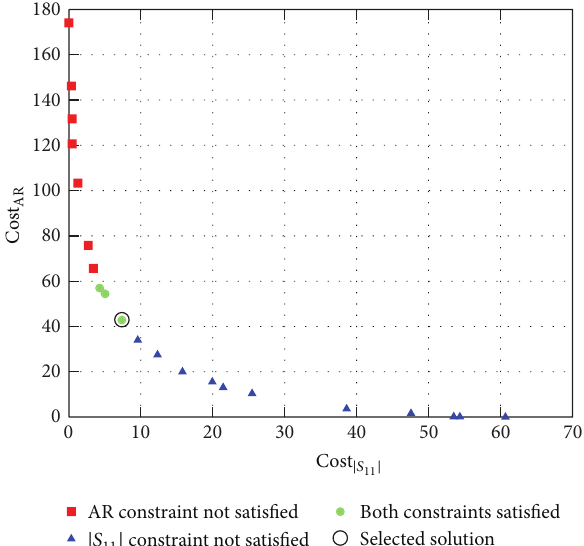
Figure 4: Simulated |𝑆 11 | (without hybrid coupler) of the optimized Galileo E6-band antenna, together with the − 10dB limit specified by the design requirements 84.6415